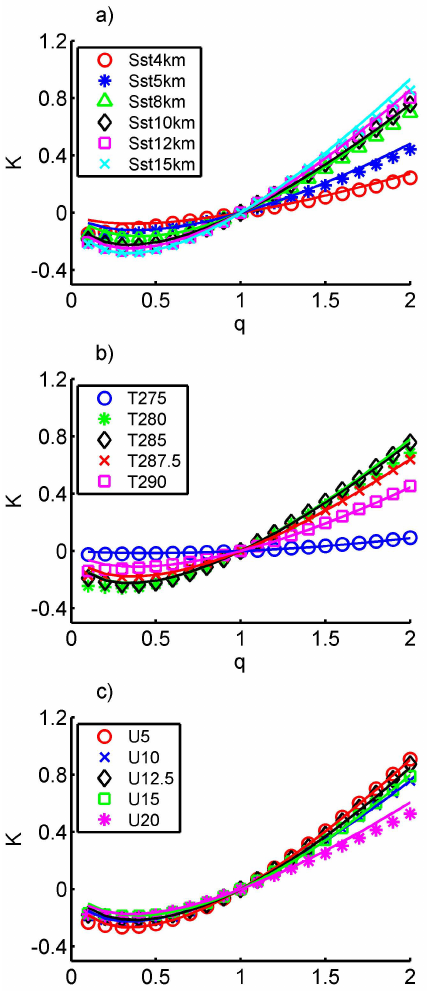
Fig. 3. Relationship between M q and λ for different values of q . M q is computed from P 5h ac from simulation (a) Sst5km, (b) Sst10km, (c) Sst15km. The scales considered on the analysis are marked by “o” while “x” marks the ones not considered. The plots are on a log–log scale.